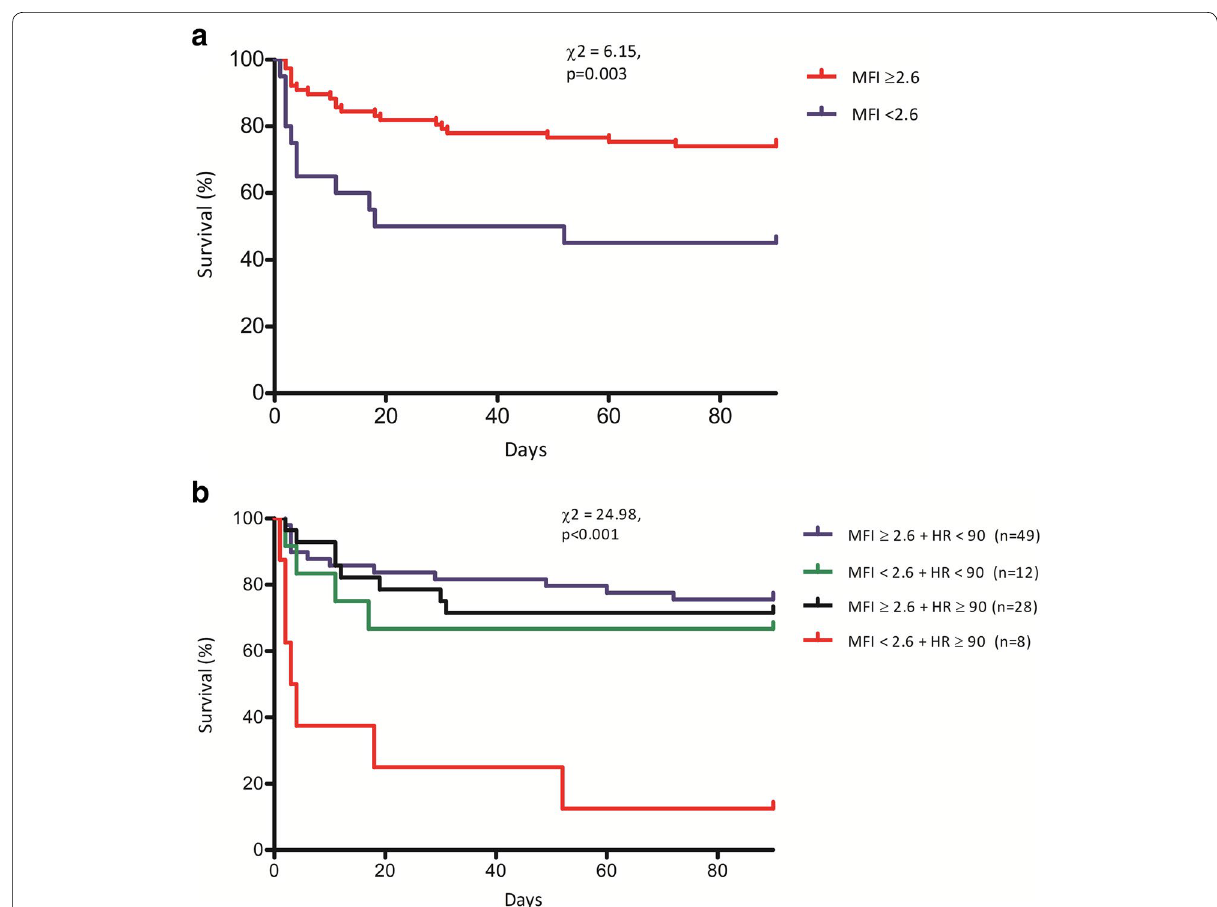
Fig. 1 Kaplan–Meier survival analysis. a Represents two subgroups, separated by microvascular blood flow (MFI) < 2.6 versus MFI sents four subgroups, separated by MFI with identical cut-off value and heart rate (HR)